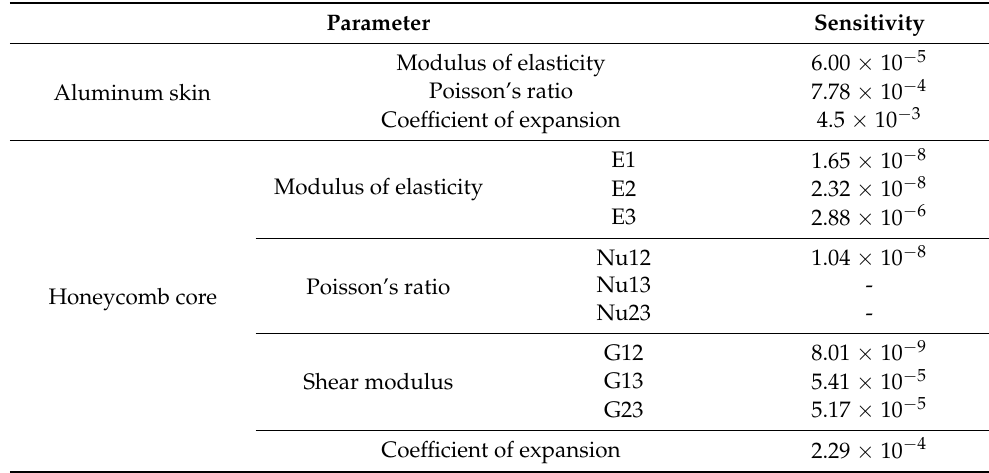
Figure 14. Calculation error of initial model at key positions ( a ) X-direction ( b ) Y-direction ( c ) Z-direction. Table 5. Parameter sensitivity analysis results.